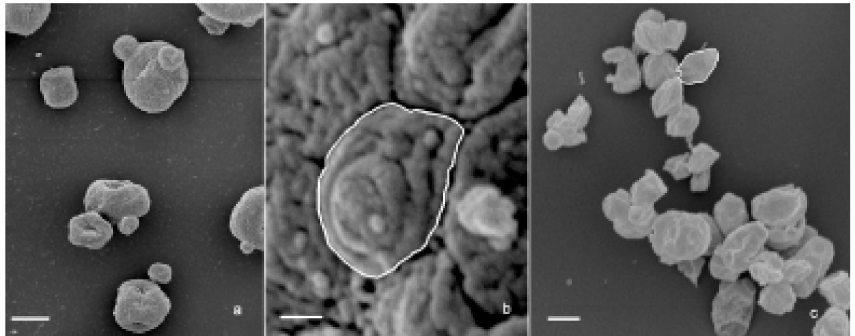
Figure 6. ( a ) Optical image of paramylon granules extracted from WZSL mutant. Bar: 2 µ m. ( b ) SEM image of paramylon granules. Bar: 200 nm. ( c ) SEM image of paramylon sonicated and alkalized showing its linear fibrous structure. Aggregation is due to the SEM preparation procedure (gold coating thickness about 10 nm). Bar: 400 nm.